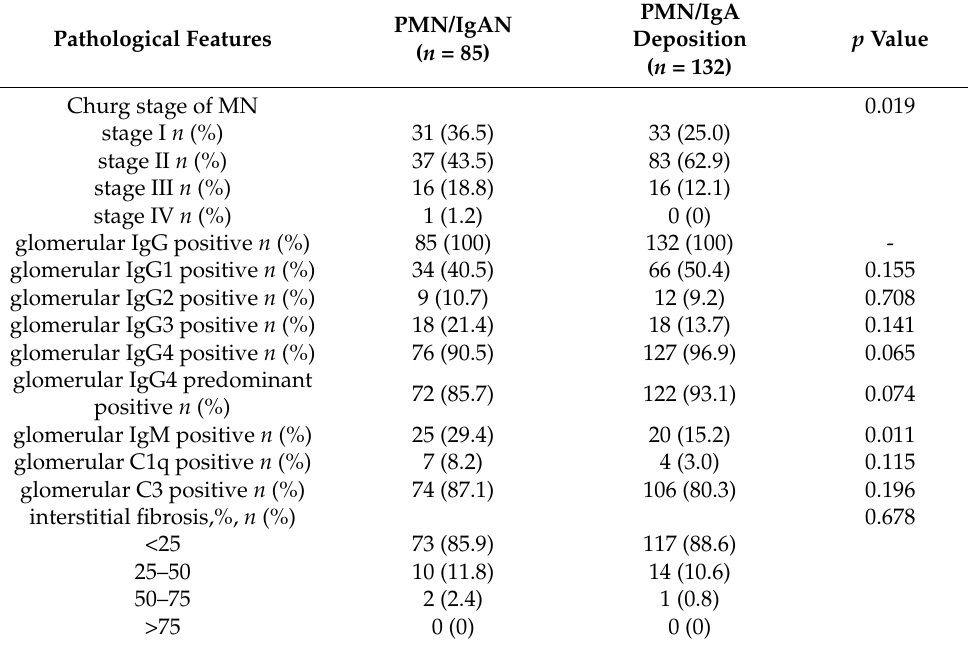
Table 2. Pathological features of patients with PMN/IgAN and PMN/IgA deposition.